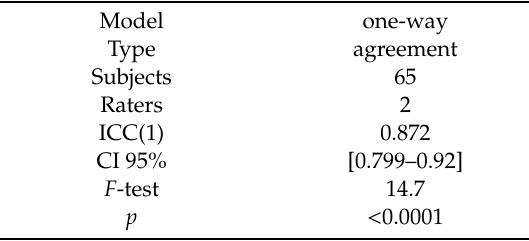
Table 3. Summary of the intra-class correlation analysis. The one-way random single score ICC